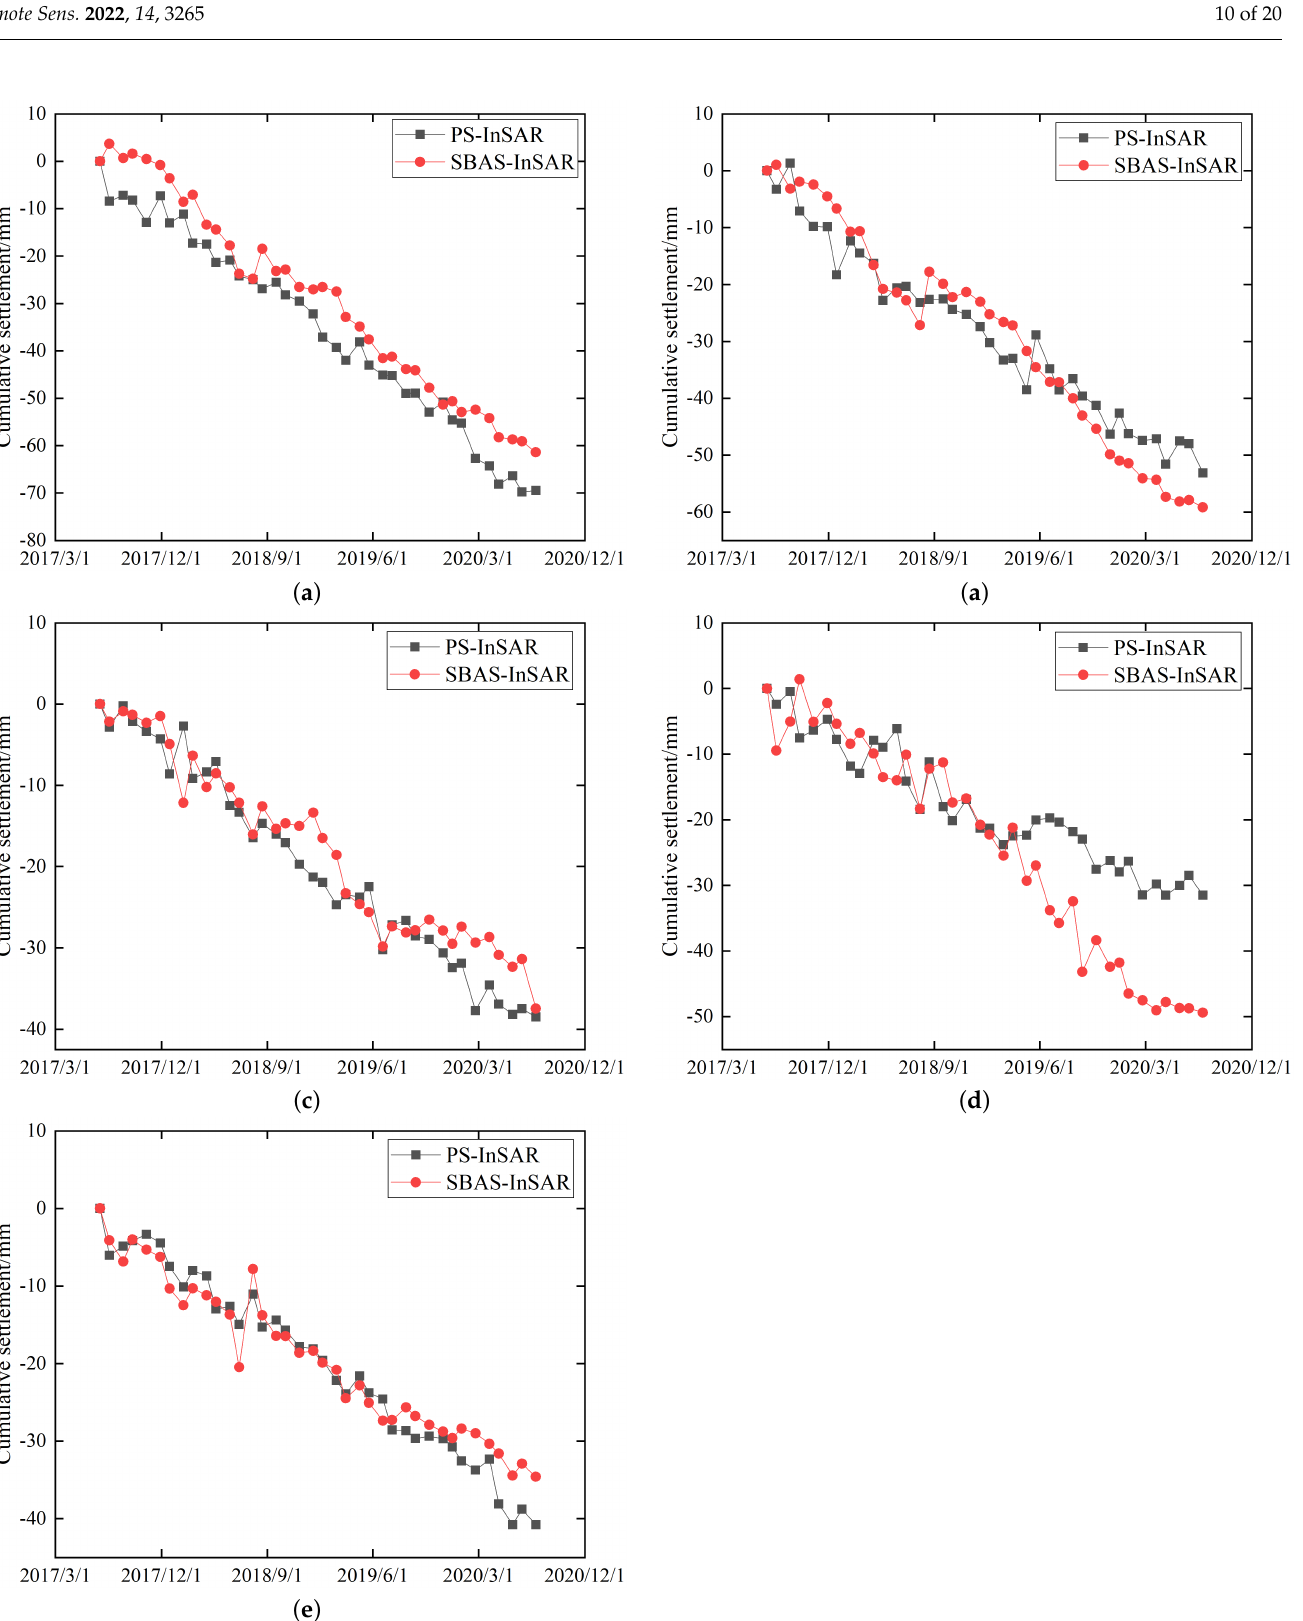
Figure 8. Time series of land subsidence rates obtained from PS-InSAR and SBAS-InSAR monitoring. ( a ) Feature point a near the 98# well. ( b ) Feature point b near the 48# well. ( c ) Feature point c near the 15# well. ( d ) Feature point d in the suburbs of the city. ( e ) Feature point e in the city